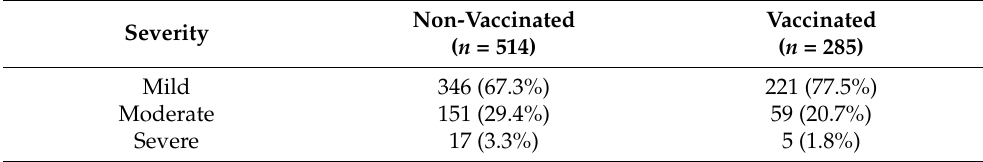
Table 3. Severity of case depending on vaccination